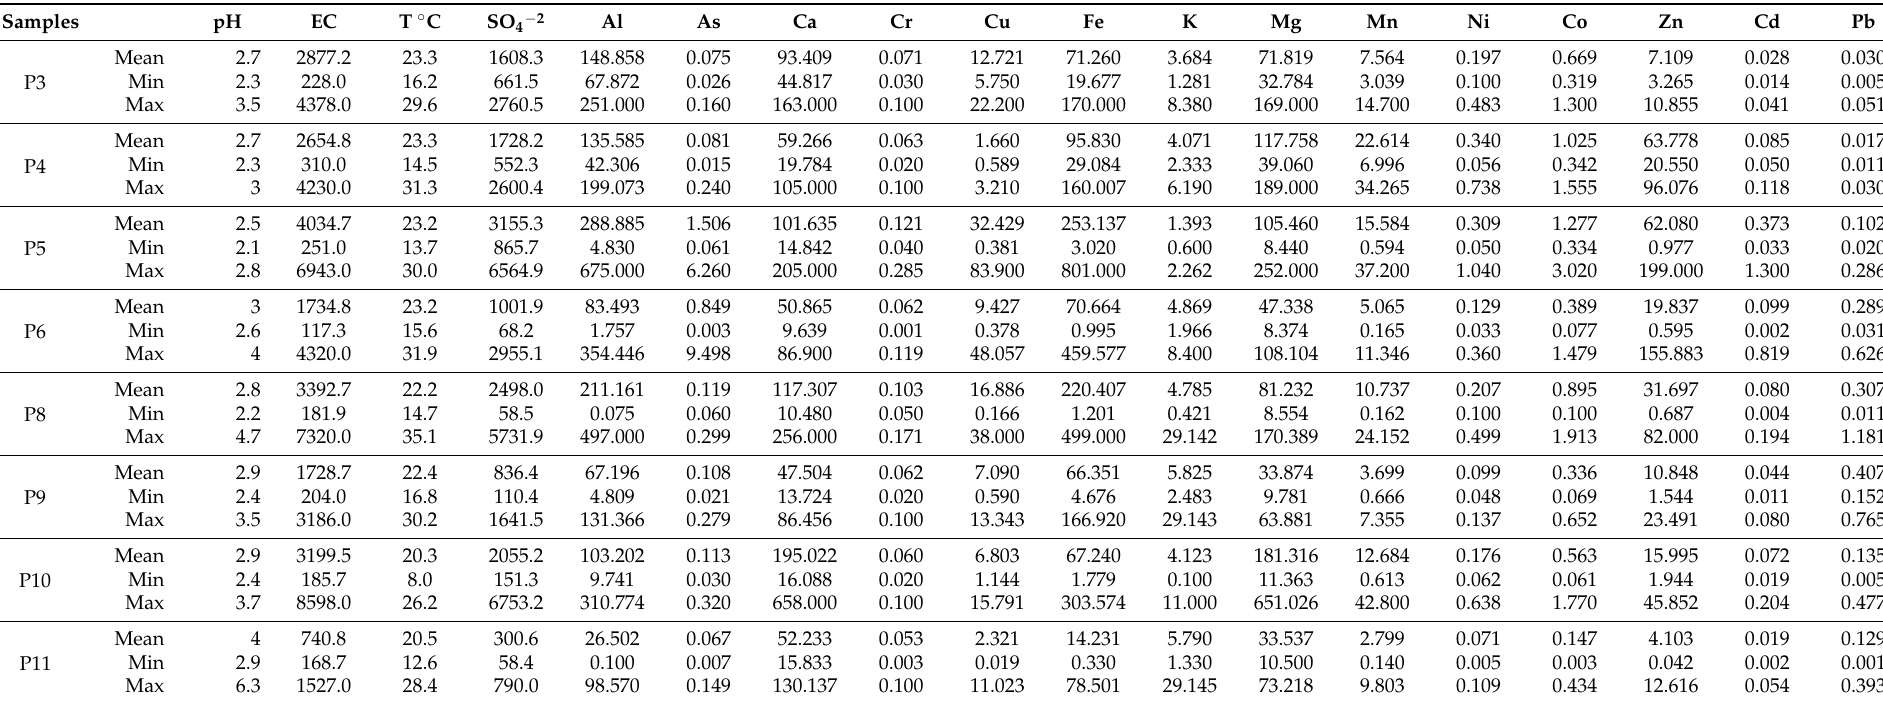
Table 1. Statistical summary of parameters analysed monthly across the hydrological year. Min = Minimum; Max = Maximum; EC = electrical conductivity ( µ S/cm); all concentrations are in